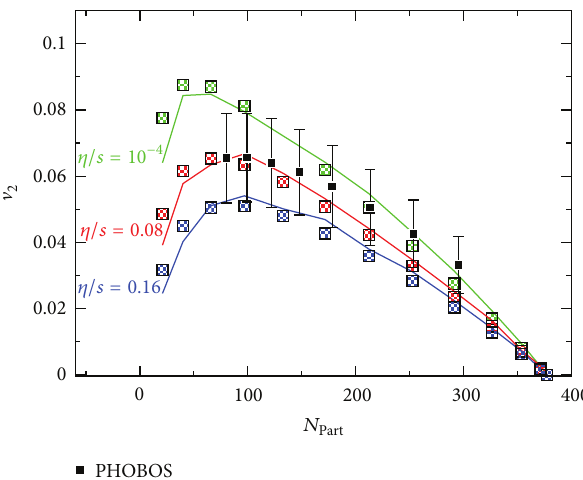
Figure 8: Centrality dependence of charged particles (integrated) elliptic flow compared with experimental data. The figure is from